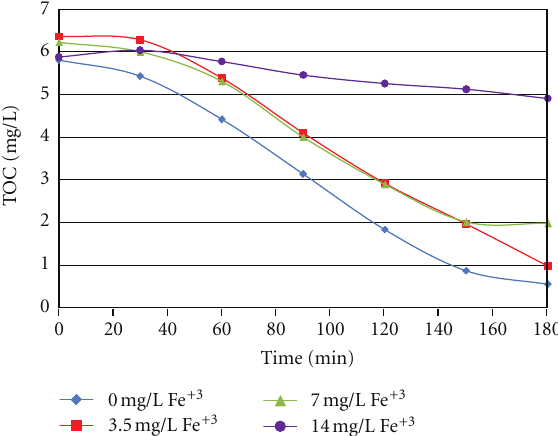
Figure 6: Behaviour of di ff erent concentrations pesticide solutions during heterogeneous photocatalysis using UV-A light and 0.5g/L TiO 2 P-25 as the catalyst.